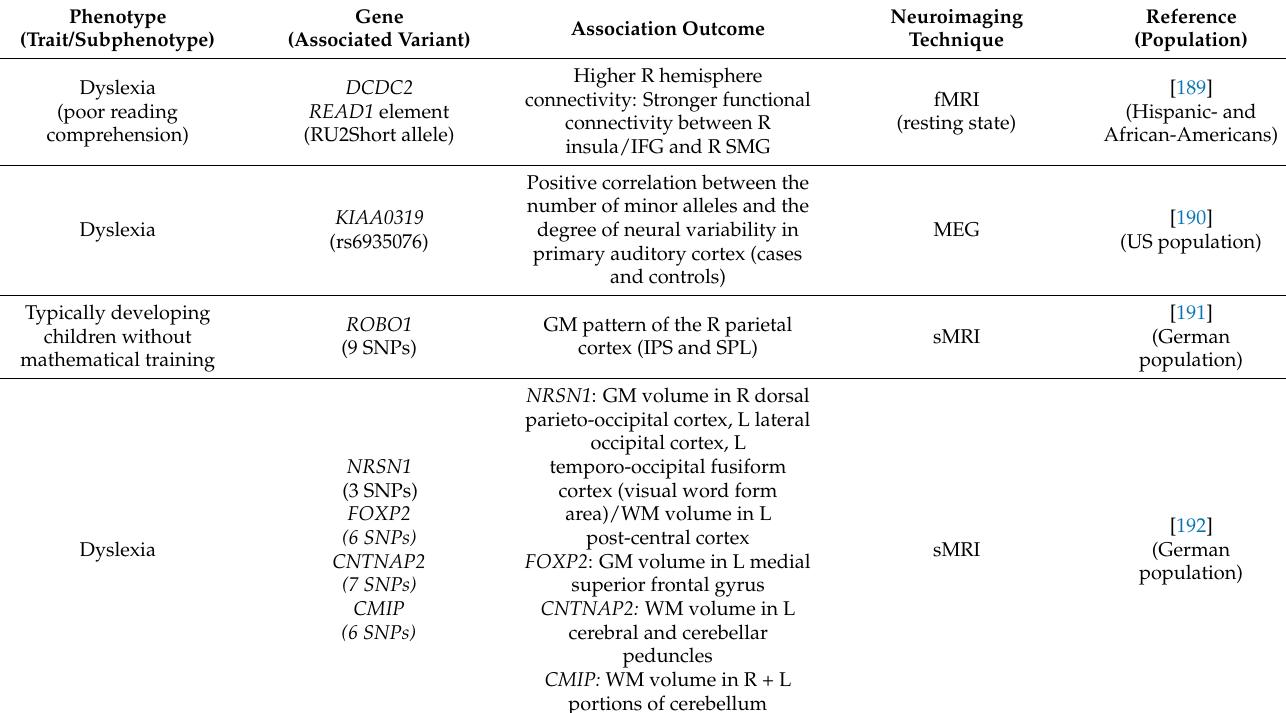
Table 4. Recent (2015-presently) neuroimaging genetic studies reporting associations between genes and genomic loci associated with reading and mathematical (dis)abilities. The list is ordered based on evidence of association for genomic loci previously associated with SLD (that is, from replicated associations to newer